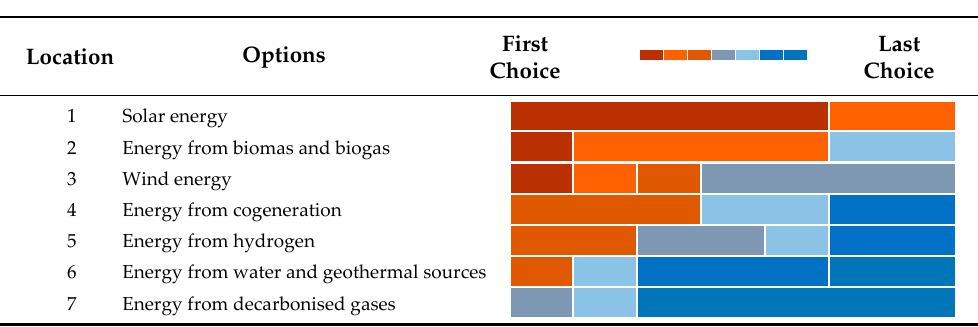
Table 3. Priorities of financial, legal, and organizational support for the development of energy sources in the macroregion of Eastern Poland in the perspective of 2030.